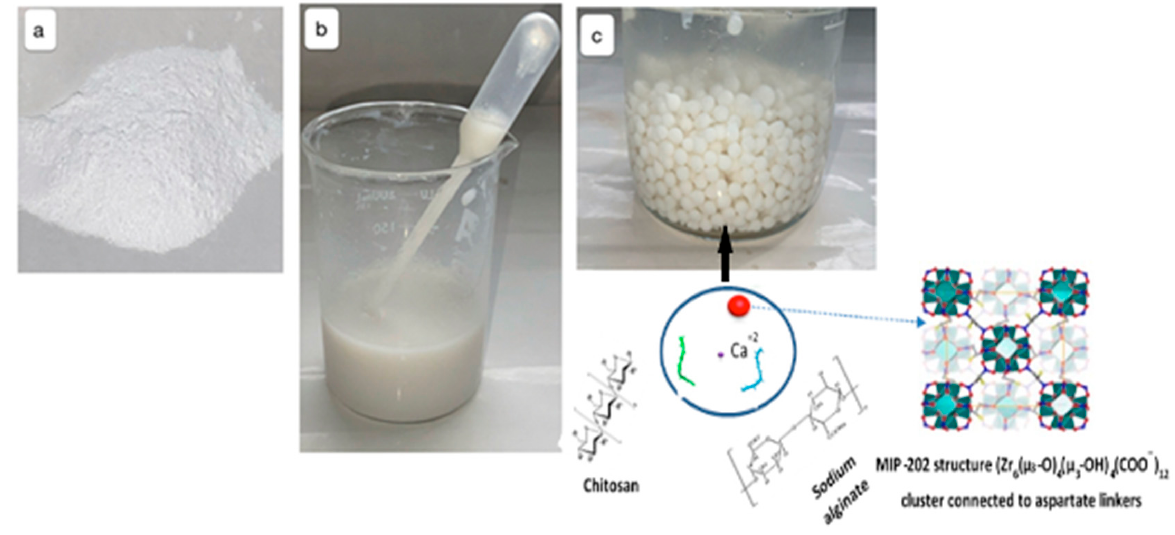
Figure 1. Fabrication of MIP-202/CA composite beads. ( a ) Powder sample of MIP-202. ( b ) MIP-202 powder sample with alginate solution. ( c ) White MIP-202/CA composite beads after washing.